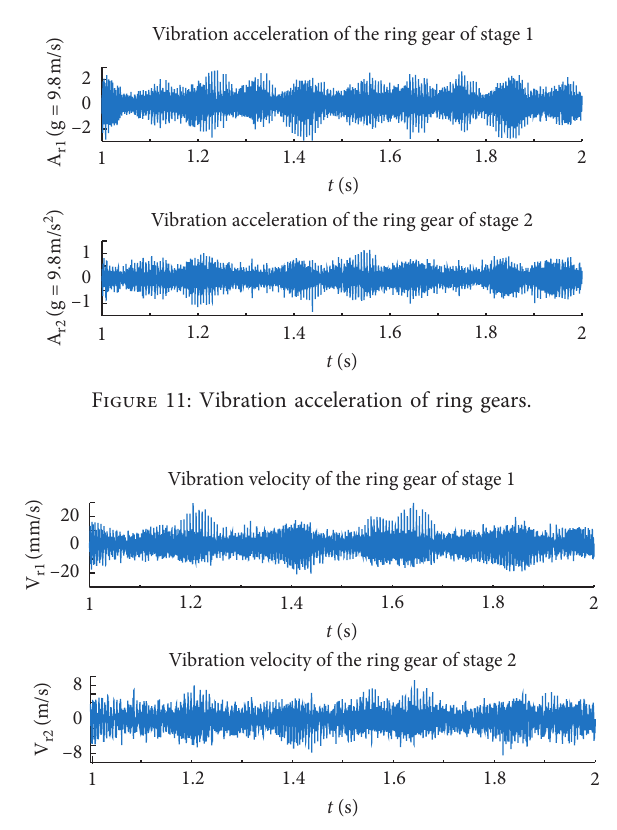
Figure 12: Vibration velocity of ring input bearing, No. 3 ～ 4 are tangential directions of the first stage of the gear ring, No. 5 ～ 6 are tangential directions of the second stage of the ring gear, and No. 7 ～ 8 are vertical and horizontal directions of the box output bearing. The test load is 504 Nm, and the input speed is 500 r/min.